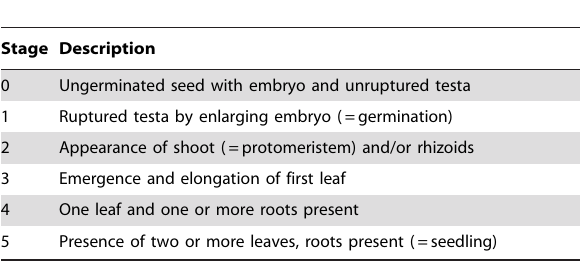
Table 1. Seed germination and seedling